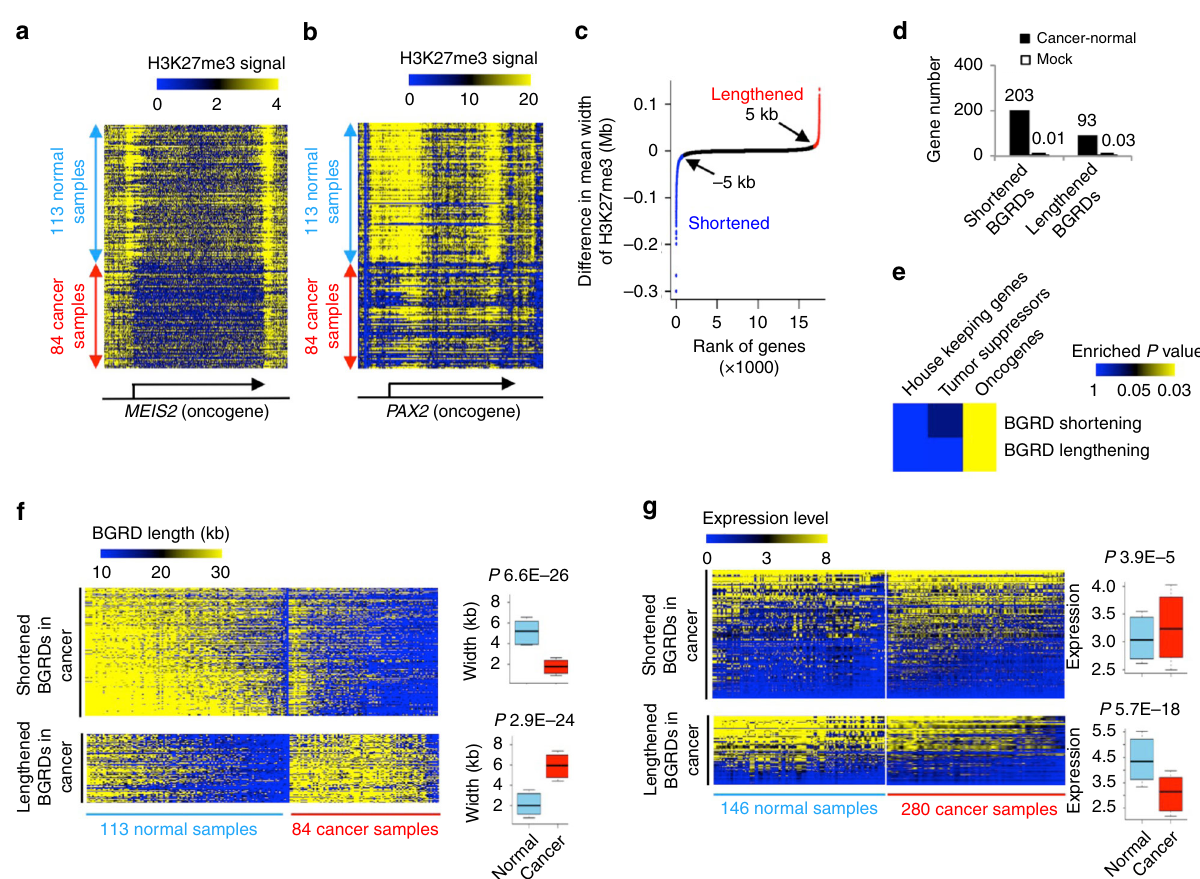
Fig. 6 Systematic pan-cancer analysis revealed widespread shortening of BGRDs at oncogenes. Heatmap to show H3K27me3 ChIP-Seq signal at individual base pairs (columns) around TSS of the oncogene MEIS2 ( a ) and PAX2 ( b ) in individual samples (rows). Arrows indicate gene loci. Gene names were indicated at the bottom. c Cumulative plot of difference in average H3K27me3 width between normal and cancer samples. Genes were ranked by difference in H3K27me3 width from the most shortened at the left side (blue) of X -axis to the most lengthened (red) at the right side. d Number of genes that displayed shortening or lengthening of BGRDs in 84 cancer cell samples relative to 113 non-cancer cell samples. Mock analysis was performed after shuf fl ing sample labels to randomly assign 84 samples as mock cancer samples. Data are presented as mean ± SD. e Heatmap to show one tail Fisher ’ s exact test P value for the signi fi cance of overlap between oncogenes, tumor suppressors, or housekeeping genes and genes that display lengthening or shortening of BGRDs in 84 cancer cell samples relative to 113 non-cancer cell samples. Heatmap to show BGRD widths ( f ) and expression values (FPKM) ( g ) of individual genes (row) in individual samples (columns), with box plots to further indicate difference in BGRD widths or expression values between normal and cancer samples, n(shortened) = 203 and n(lengthened) = 93. Box plots: center line is median, boxes show fi rst and third quartiles, whiskers extend to the most extreme data points that are no more than 1.5-fold of the interquartile range from the box. P values determined by one tail Fisher ’ s exact test e or one tail Wilcoxon test f , g . Source data are provided as a Source Data